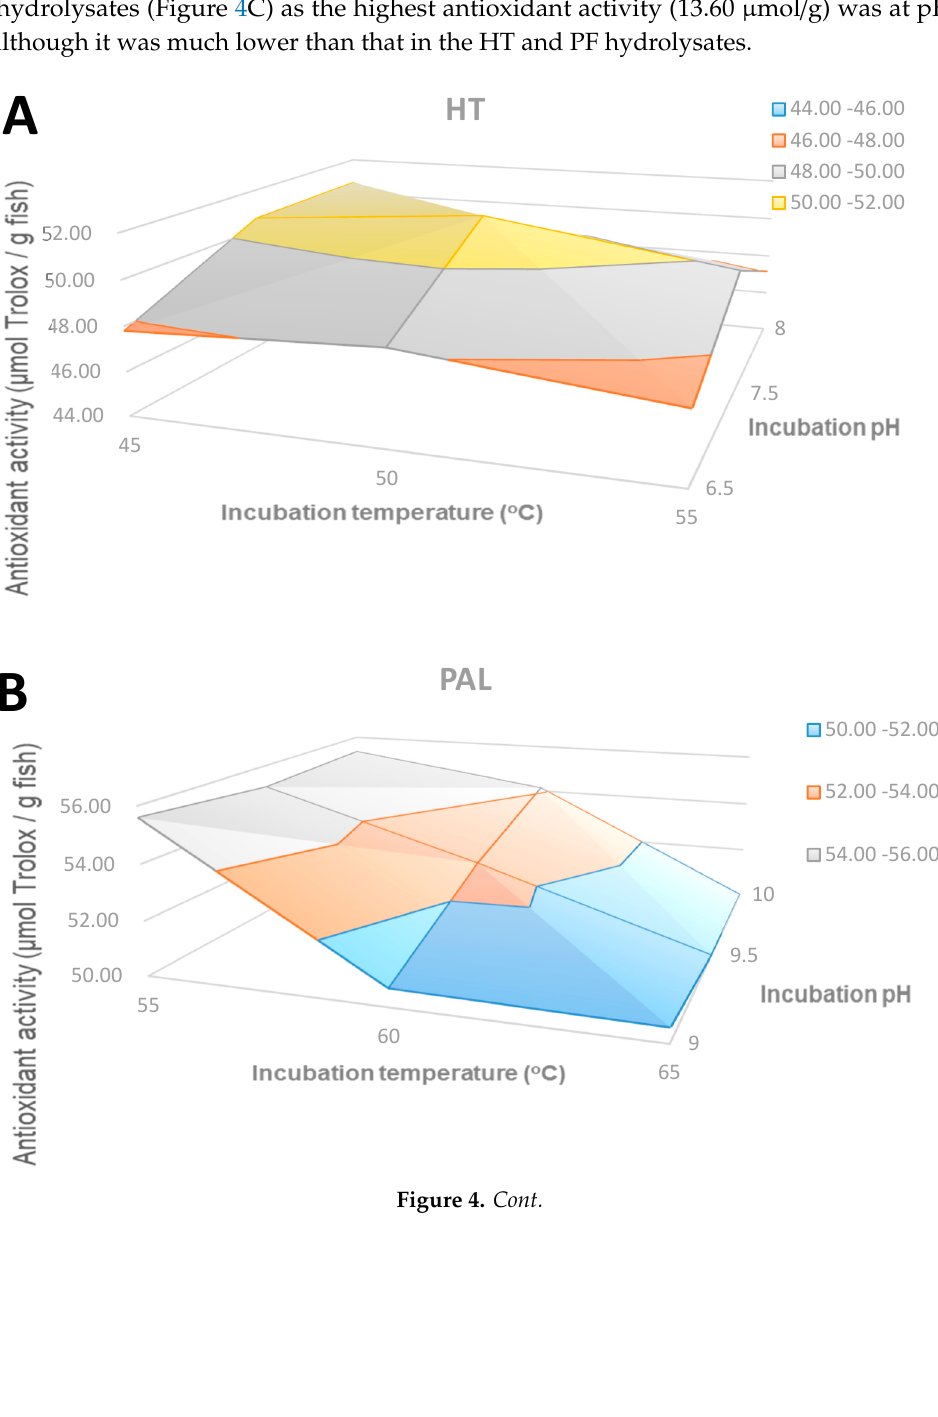
Figure 3. The antioxidant activity of hydrolysates by the FRAP method: ( A ) HT hydrolysates; ( B ) PAL hydrolysates; ( C ) PF hydrolysates.